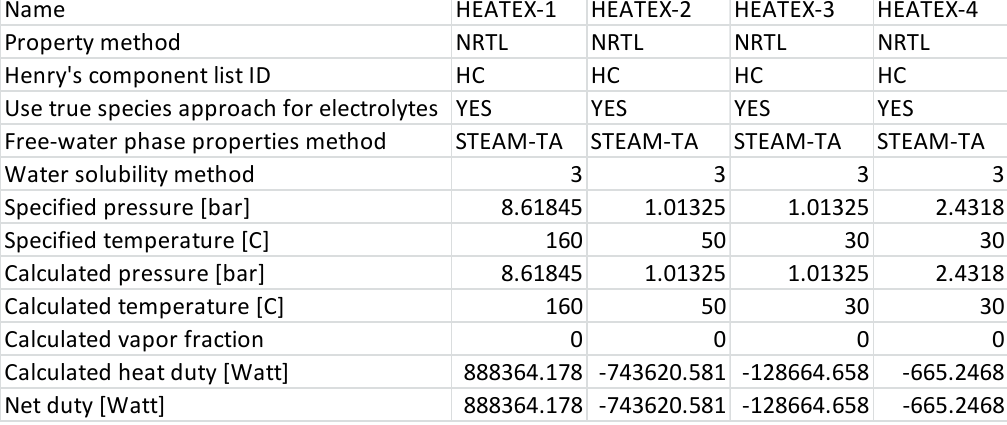
Figure A14. Fermentation heat exchanger results.